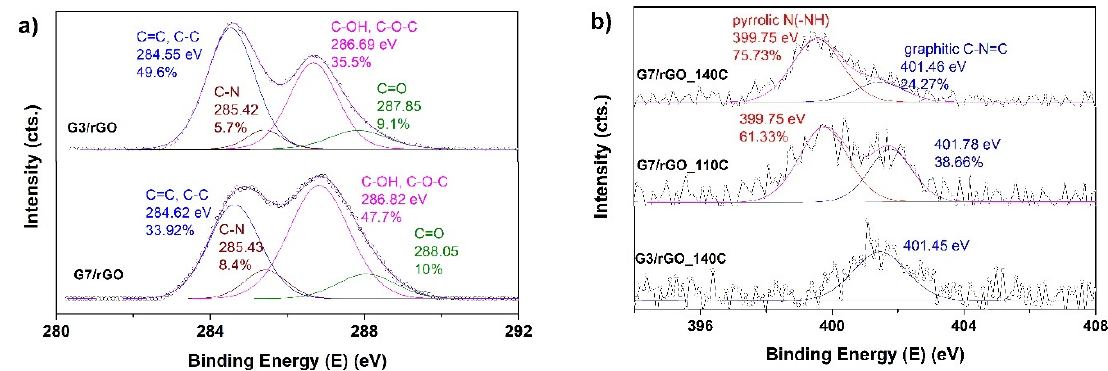
Figure 7. ( a ) High resolution XPS spectra of C1s peak for PAMAM-modified rGO aerogels obtained at 140 °C and ( b ) N1s peak for the PAMAM-modified rGO aerogels as a function of generation and T HT .